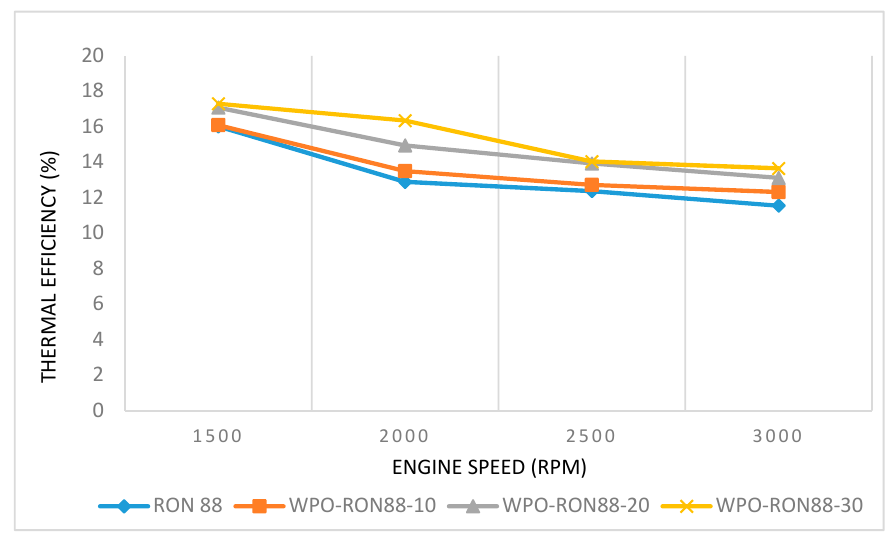
Figure 7. Effect of WPO-RON88 blend on thermal efficiency (%), compared to RON88. Figure 7. E ff ect of WPO-RON88 blend on thermal e ffi ciency (%), compared to